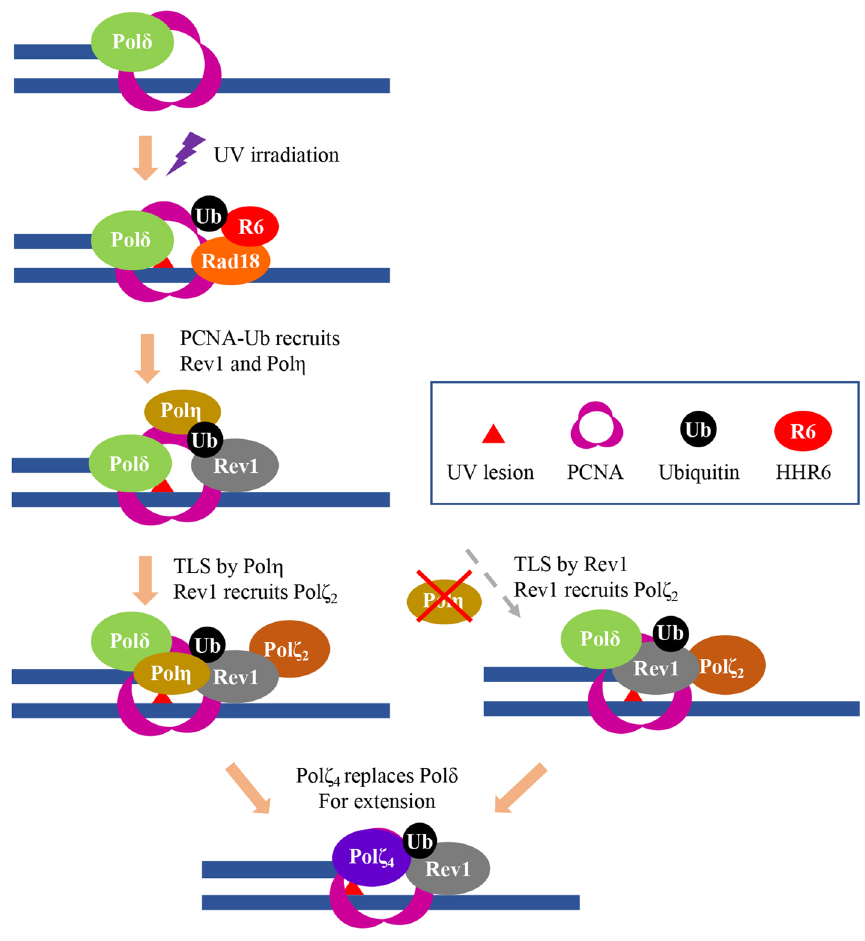
Figure 7. Proposed working model for TLS in response to UV irradiation in mammalian cells. UV irradiation induced DNA damage blocks replicative polymerase like Polδ. The ssDNA along with stalled replication fork recruits the Rad6-Rad18 complex to monoubiquitinate PCNA-K164, which in turn recruits both Polη and Rev1. A default pathway is for Polη to insert nucleotides opposite the lesion, and for Rev1 to recruit Rev7-Rev3 (Polζ 2 ) to the damage site to form Polζ 4 for extension, in which the Polη-Rev1 interaction plays a crucial role. In the absence of Polη, Rev1 can play dual roles in both insertion and Polζ 2 recruitment, in which its catalytic activity is